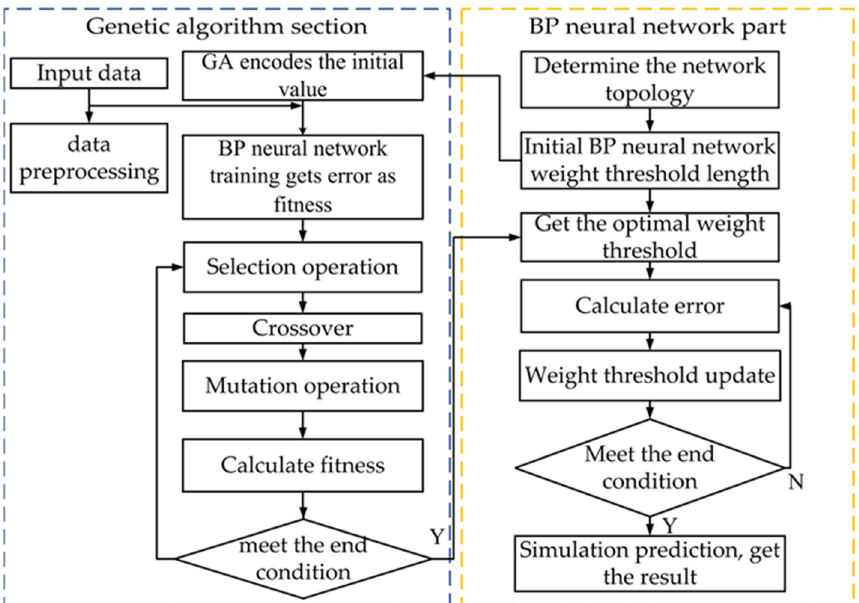
Figure 31. Flowchart of the basic algorithm of GA-BP neural network. Table 4. GA-BP neural network model parameters.